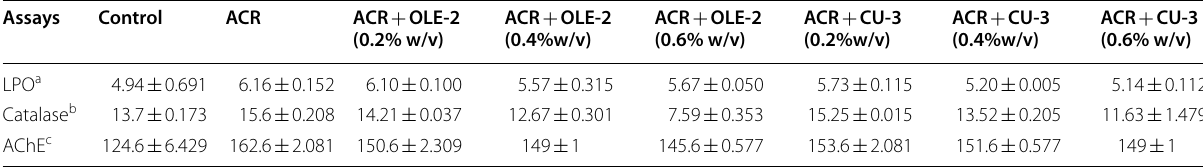
Data analysed by one-way ANOVA followed by Tukey’s test for comparison of control, ACR (8 mM) and co-exposed with ACR concentrations Mean SD ± a Lipid peroxidation (LPO), MDA nM/mg